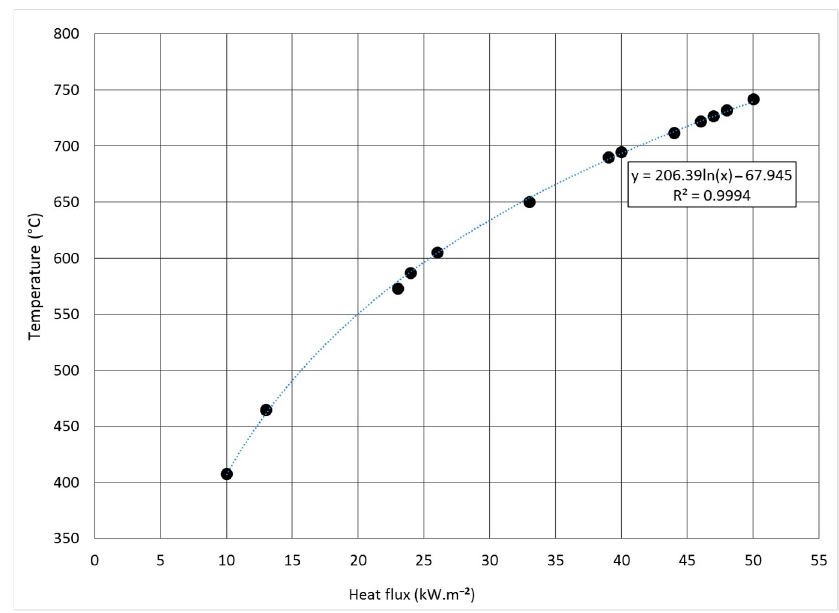
Figure 2. Heat flux dependence on cone calorimeter